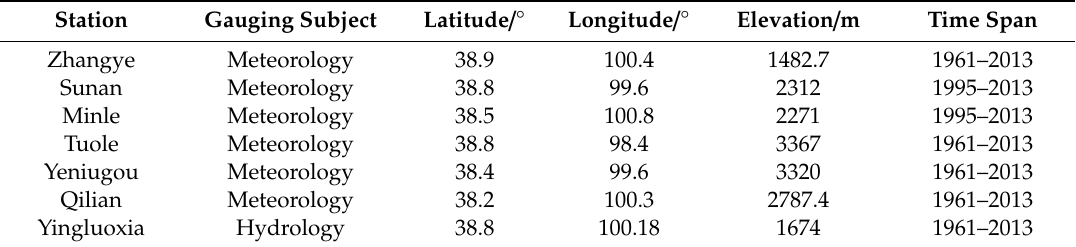
Table 1. Properties of the hydrometeorological stations in and around the upper watershed of Heihe River.